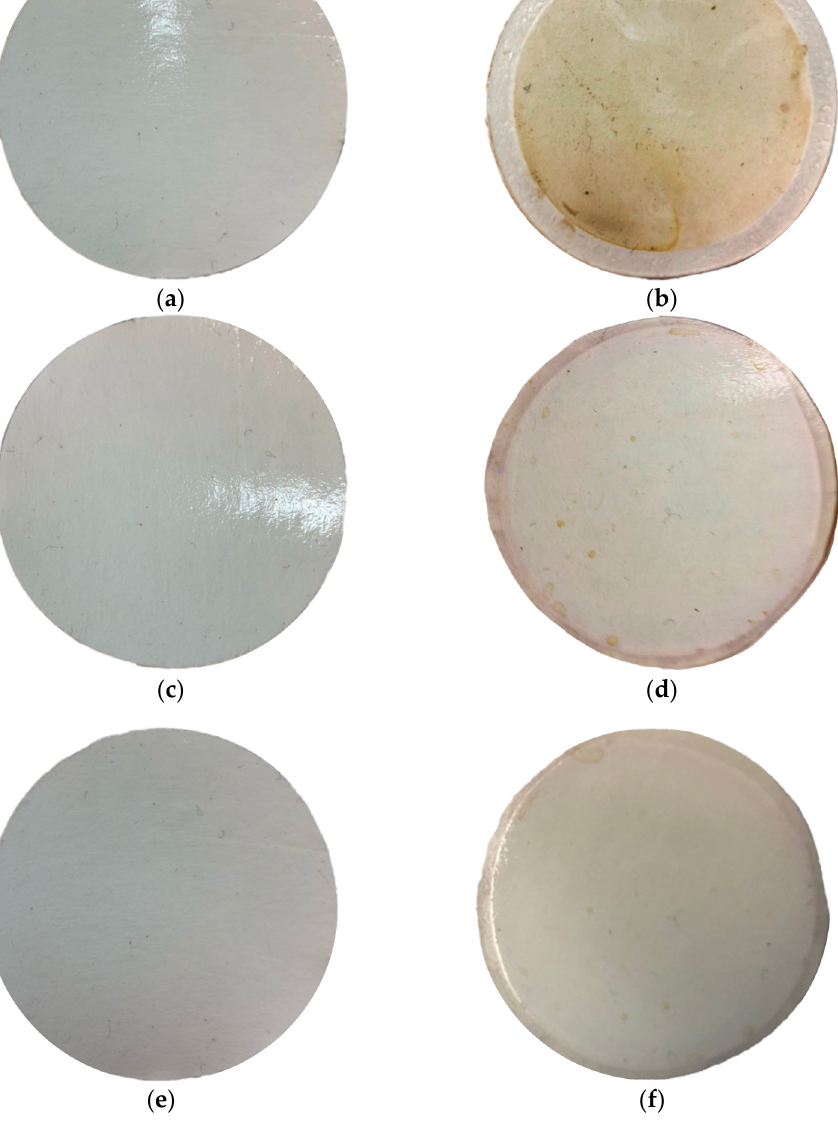
Figure 4. Photographs of membranes before: ( a ) PDecMS; ( c ) PHeptMS; ( e ) MDK-3 and after one month of contact with ABE-fermentation broth: ( b ) PDecMS; ( d ) PHeptMS; ( f ) MDK-3.